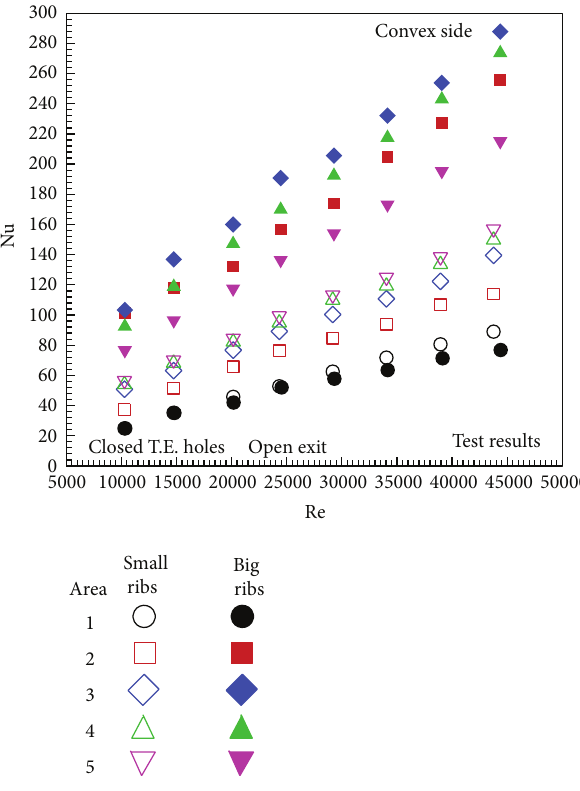
Figure 17: Measured Nusselt number variation with the local Reynolds number on all areas on the convex wall for the two rib geometries, open trailing-edge holes, and 1/2 blocked channel